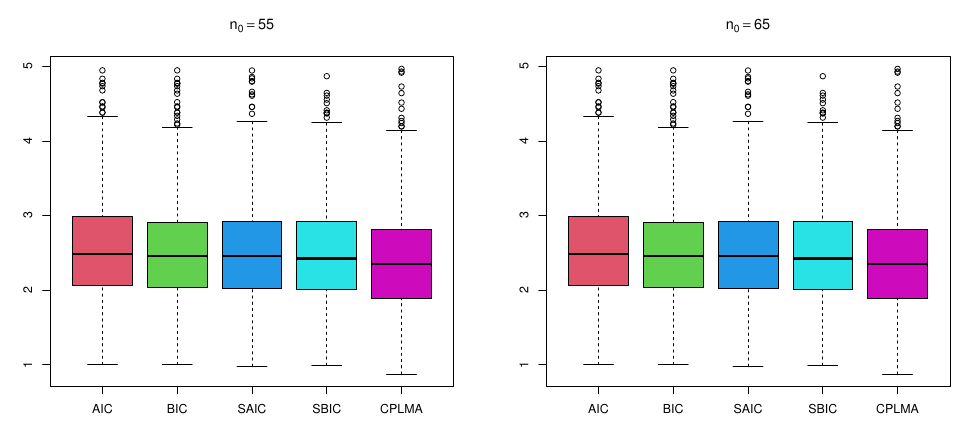
Figure 10. Boxplots for MSPEs of five methods for the MCL